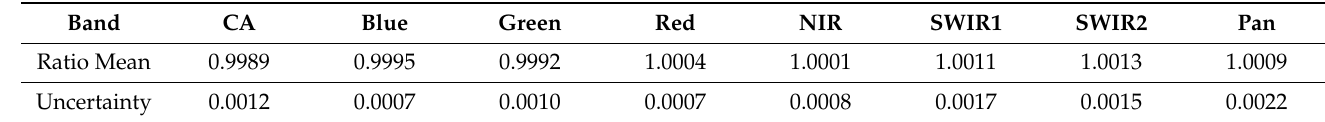
Table 10. Spectral uncertainty table. Uncertainty units are